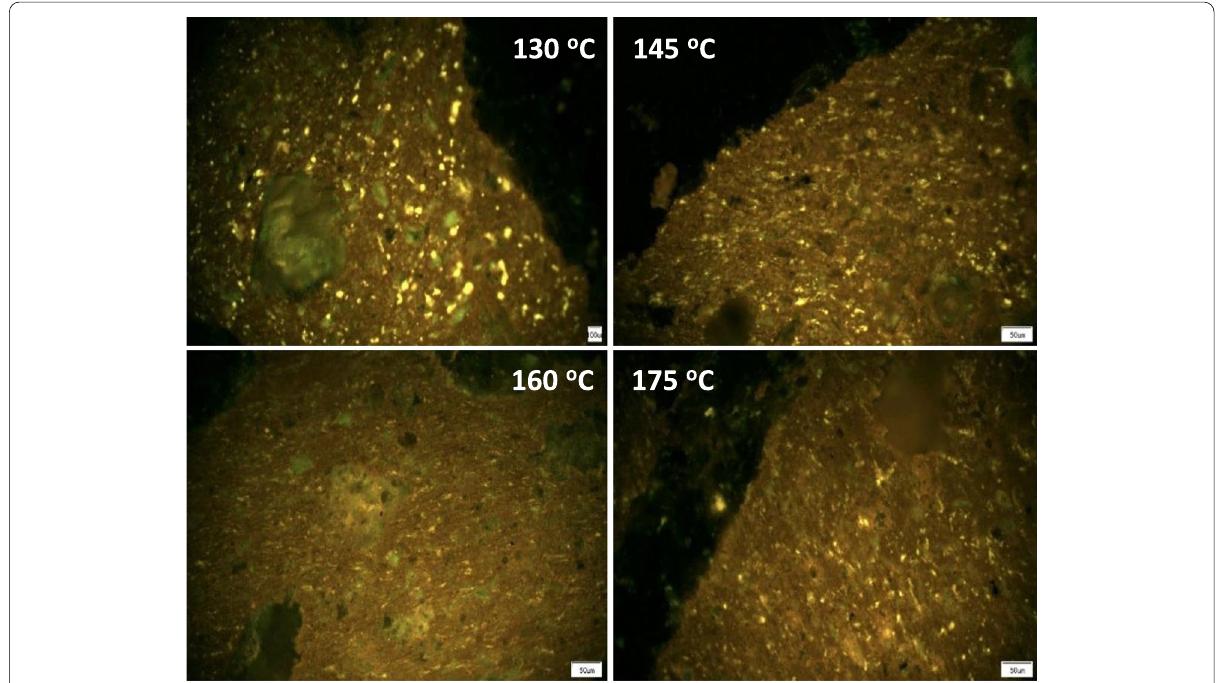
Fig. 8 Fluorescence images of SBS modifier in mixtures at different conditioning temperature (image size: 1.4 mm